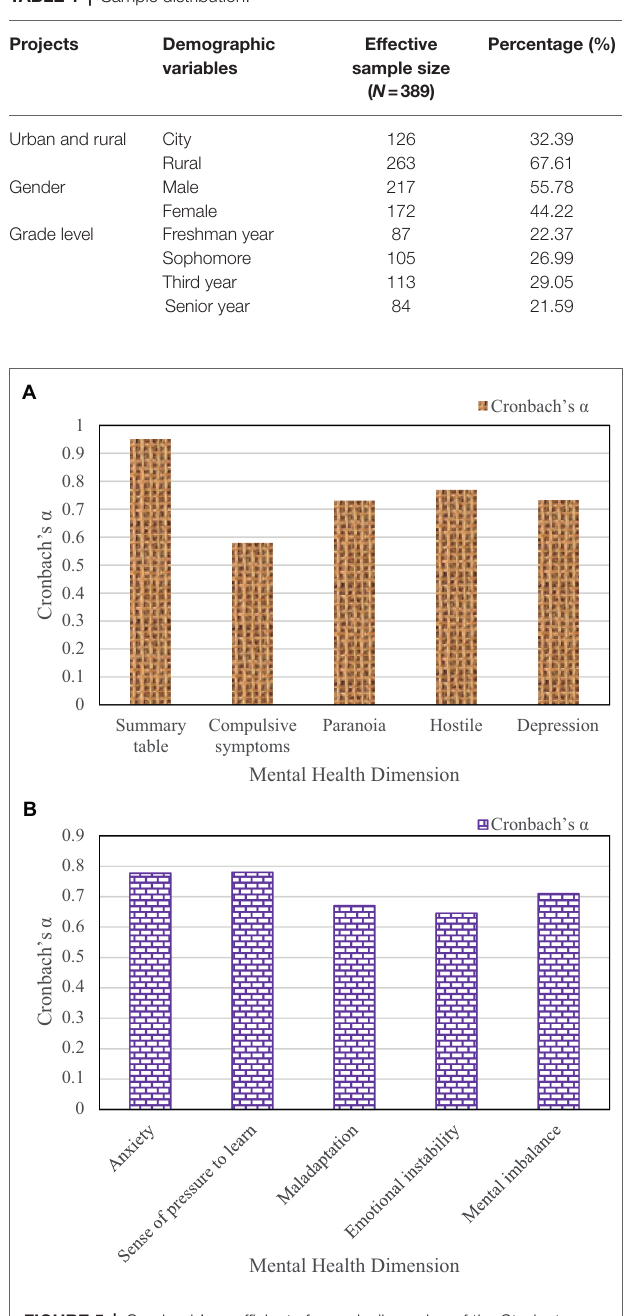
FIGURE 5 | Cronbach’s coefficients for each dimension of the Student Mental Health Rating